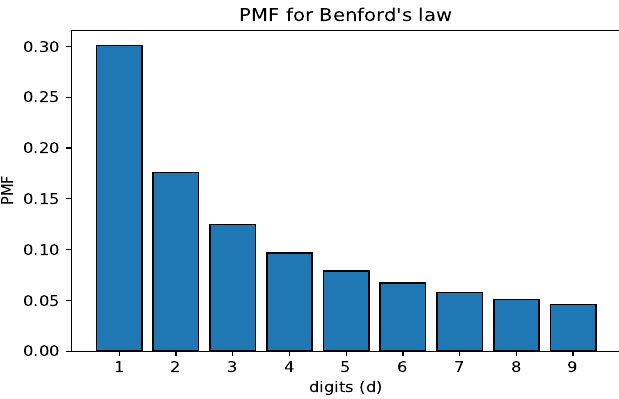
Figure 2. Probability Measure for Benford’s Law in Base